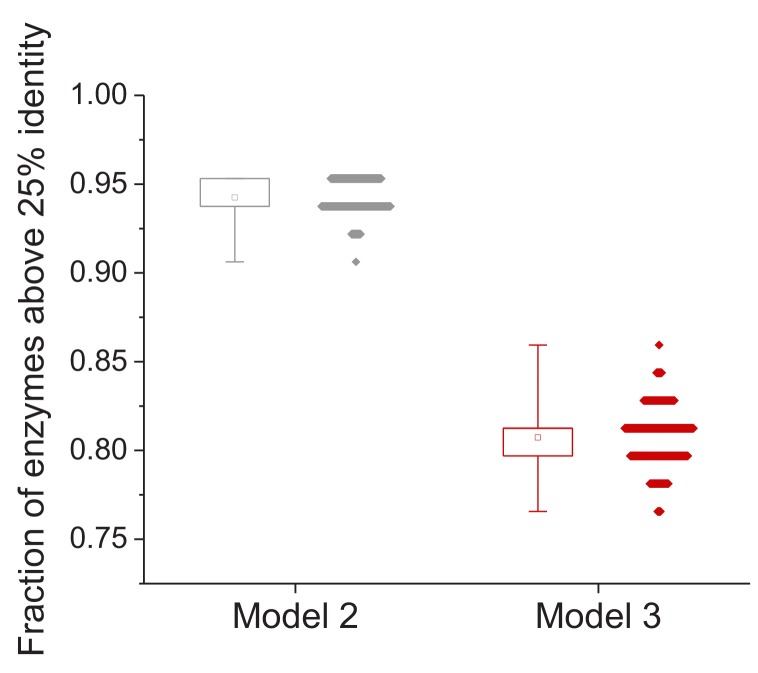
Effect of uncertainty in the estimation of species divergence times on the model fits.Effect of different estimates of species’ divergence times on the predicted long-term sequence identity between orthologous enzymes with the same molecular function. The data on the left shows the fraction of enzymes for which the Model 2 Y0 parameter is higher than 25% sequence identity; each dot corresponds to a different assignment of lineage divergence times (based on either minimum or maximum literature estimates; see Materials and methods). The data on the right shows the fraction of orthologous enzymes for which the predicted sequence identity after 7.8 billion years of divergence is higher than 25% identity. The box plots show the minimum and maximum values and 25% and 75% percentiles based on 1000 divergence time assignments.